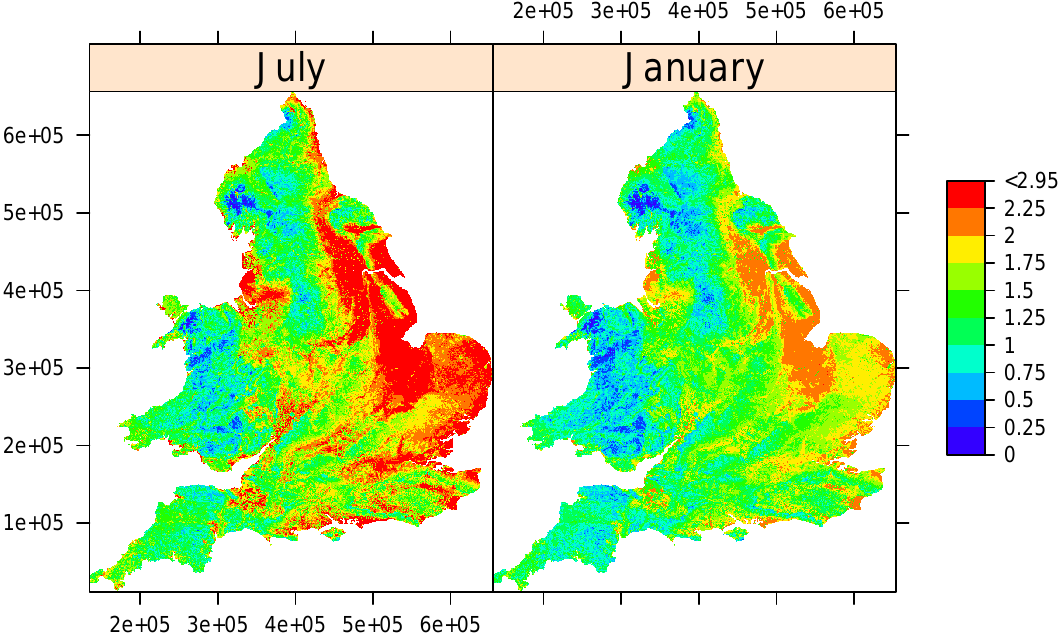
Fig. 7. Predicted free CO 2 -C concentration (mgL − 1 ) in flow for a 1km grid across England and Wales: May and November. Coordinates are metres on the British National Grid. Note the maximum class limit is greater than the arithmetic scale used in the other classes. Table 5. Summary of the ordinary least squares model used for the prediction of daily headwater stream temperature for the 1km grid across England and Wales. Year day (yrday) is the transformed numeric value of day in the calendar year. A colon (:) denotes inclusion of an interaction (a product term) of